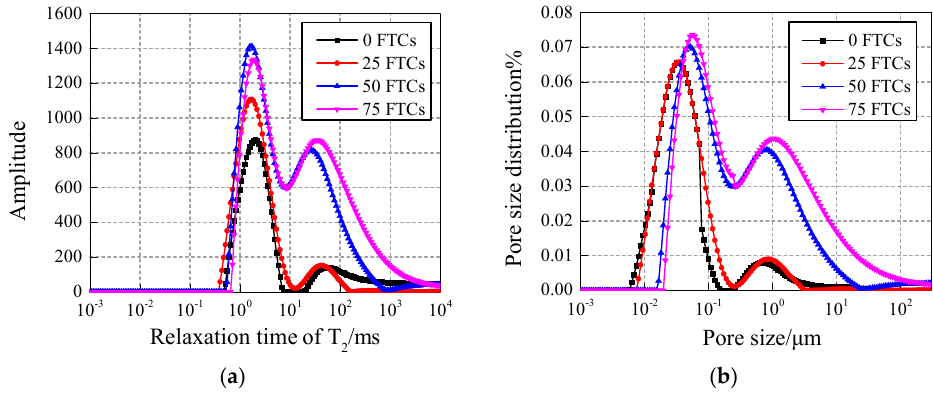
Figure 7. ( a ) T 2 spectrum and ( b ) pore fluid size distribution of 30 nm-NS specimens. The curves of the 15 nm-NS and 30 nm-NS specimens show the trend of increasing peak point and right pendulum with the increase of freezing and thawing cycles, which indicates that the number, size, and volume of the pores in the specimen are increasing continuously. (2) Analysis of the effect of different sizes of NS on the pore size distribution under different freezing and thawing cycles.